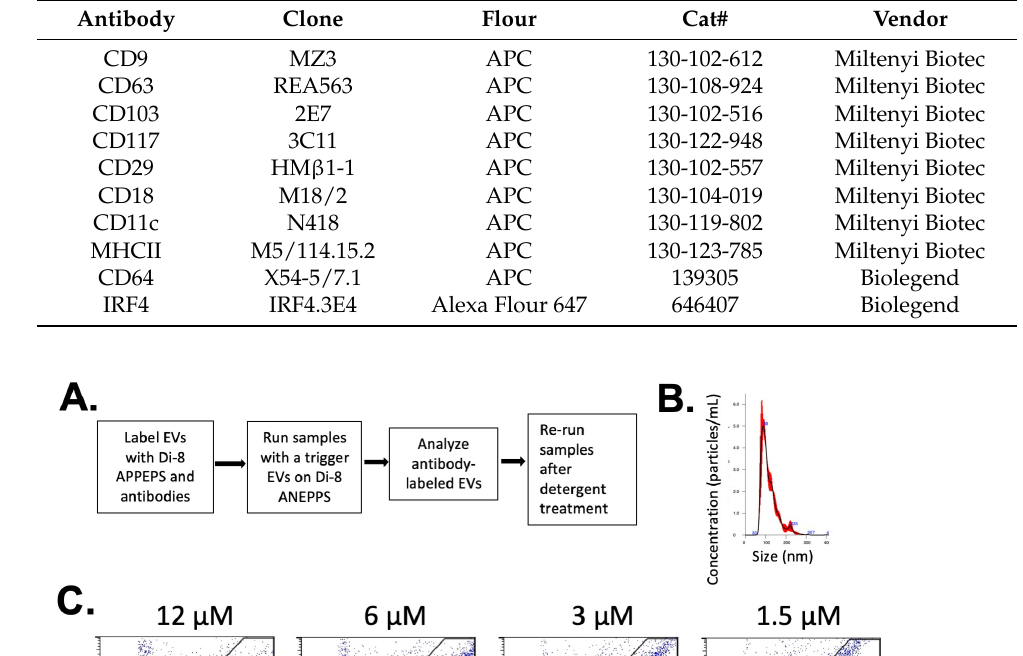
Table 1. Antibodies used for analysis of EV surface markers using vesicle flow cytometry.